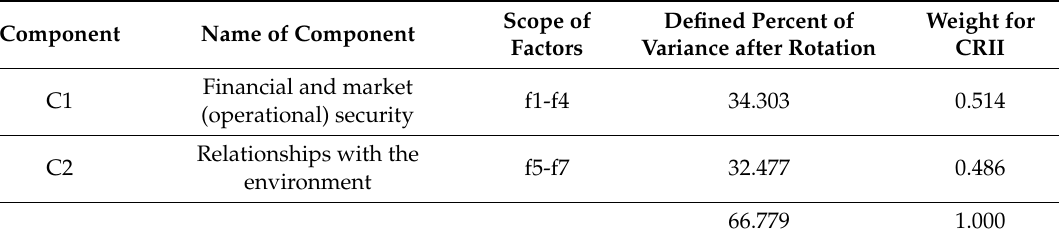
Table 21. Descriptive statistics for CCCI two components of CCCI.